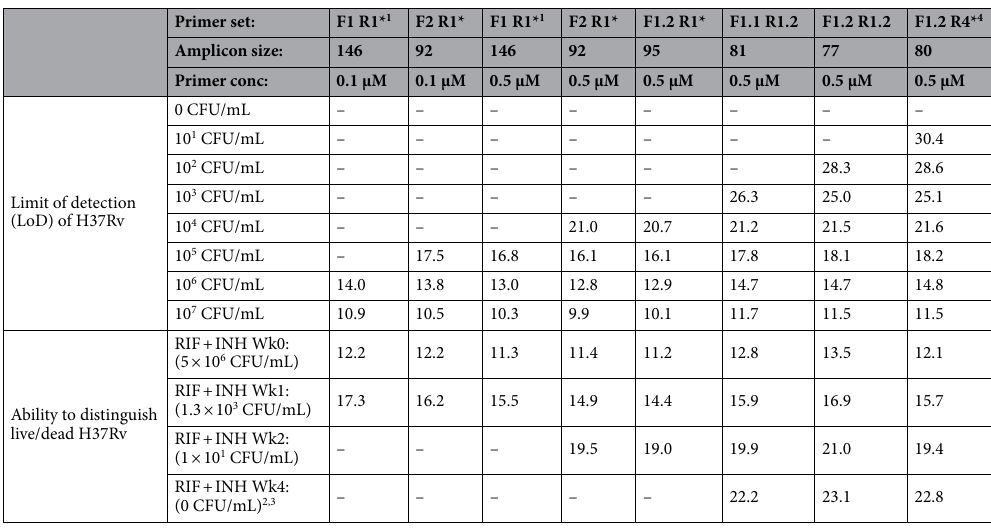
Table 4. Average qRTPCR cycle threshold values for eight different 16S rRNA qRTPCR reaction conditions (consisting of various primer combinations and concentrations) tested on serial dilutions of H37Rv spiked into non-Mtb containing sputum (top), or log-phase H37Rv killed by rifampin (RIF) and isoniazid (INH) over the course of 4 weeks (bottom). The first five primer sets with LoDs of ≥ 10 4 H37Rv/mL are able to distinguish live from dead H37Rv, whereas the remaining primer sets with lower LoDs are not. Primers sets chosen for subsequent experiments are indicated by *. Wk week, conc concentration, CFU colony forming unit,